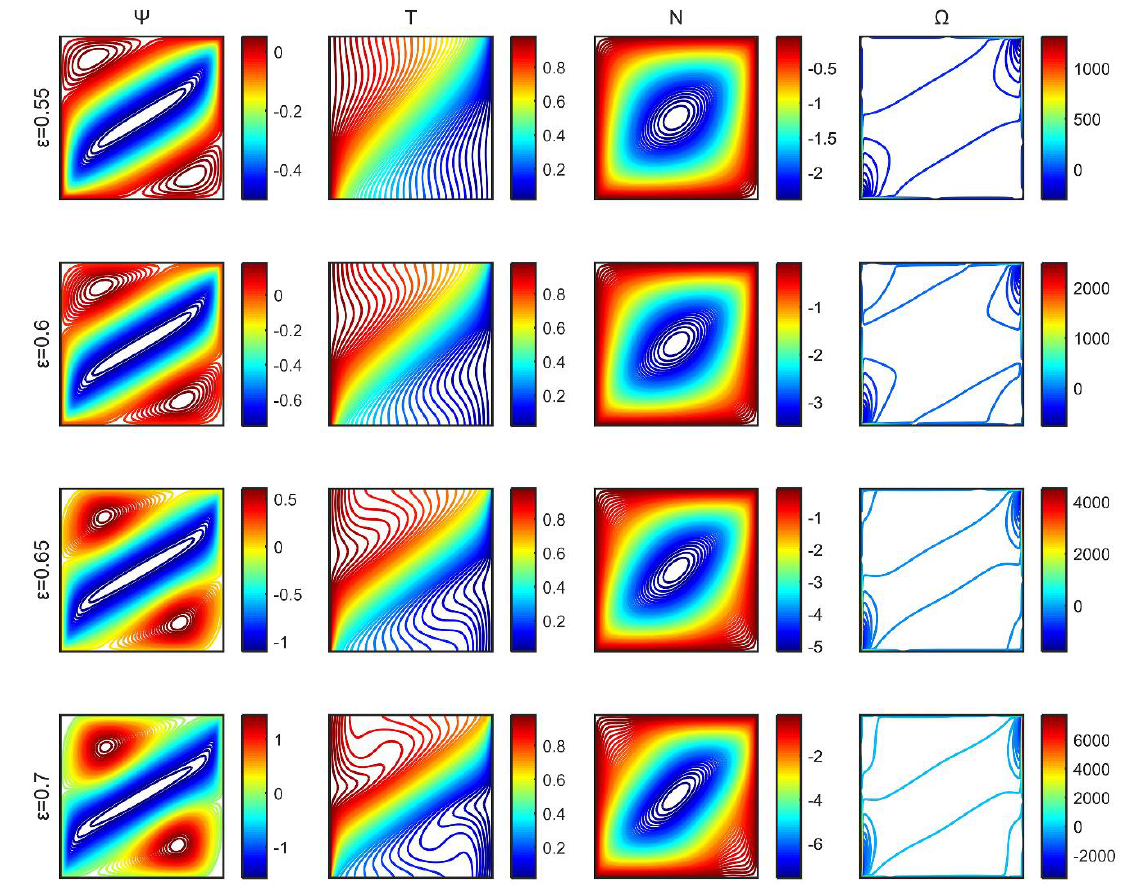
Figure 4. Stream function ( Ψ ), temperature ( θ ), microrotation ( N ), and vorticity ( Ω ) contours for a Figure 4. Stream function ( 𝛹 ), temperature ( 𝜃 ), microrotation ( 𝑁 ), and vorticity ( 𝛺 ) contours for a range of porosities of the range of porosities of the medium.